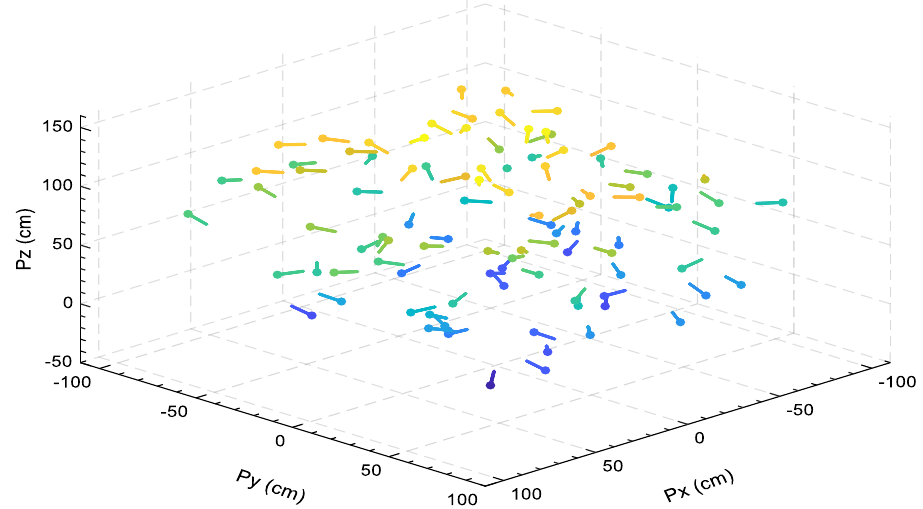
Figure 12. Randomly generated pose points in the workspace of the manipulator.